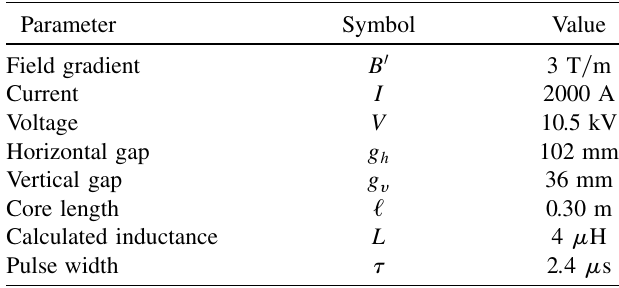
TABLE III. Specifications of the PQM system.